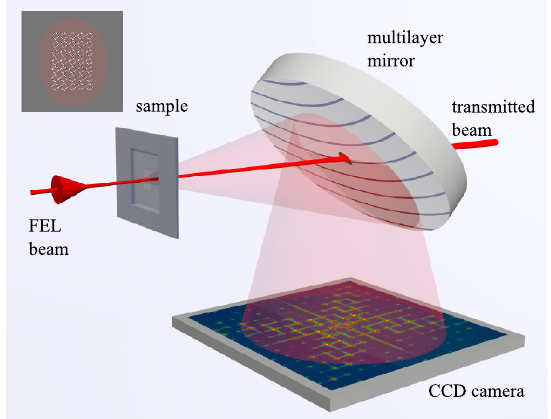
FIG. 2. Schematic illustration of the experiment. After passing through the optics and beam-cleaning aperture, the ∼ 25 - μ m focused FEL beam illuminates the SiN sample window. The direct FEL beam passes through a hole in the 45° multilayer mirror that reflects the diffracted x rays to the CCD camera. The inset at the top left shows the approximate illumination profile of the FEL beam on a typical microcrystal target.